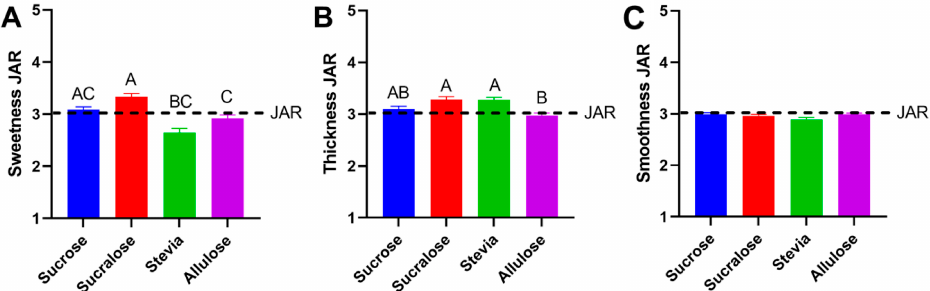
Figure 3. Just-about-right (JAR) ratings of sweetened yogurt samples. JAR data compiled from 100 sensory participants for sweetness ( A ), thickness ( B ), and smoothness ( C ). Friedman’s test followed with Dunn’s multiple comparison test was used in each set to determine statistical significance (assumed when p < 0.05) between each pair. JAR rating from 1 to 5 was described as 1 = not sweet enough, 2 = somewhat not sweet enough, 3 = just about the right sweetness, 4 = somewhat too sweet and 5 = much too sweet. Bars show mean and SEM, different letters denote statistical differences.